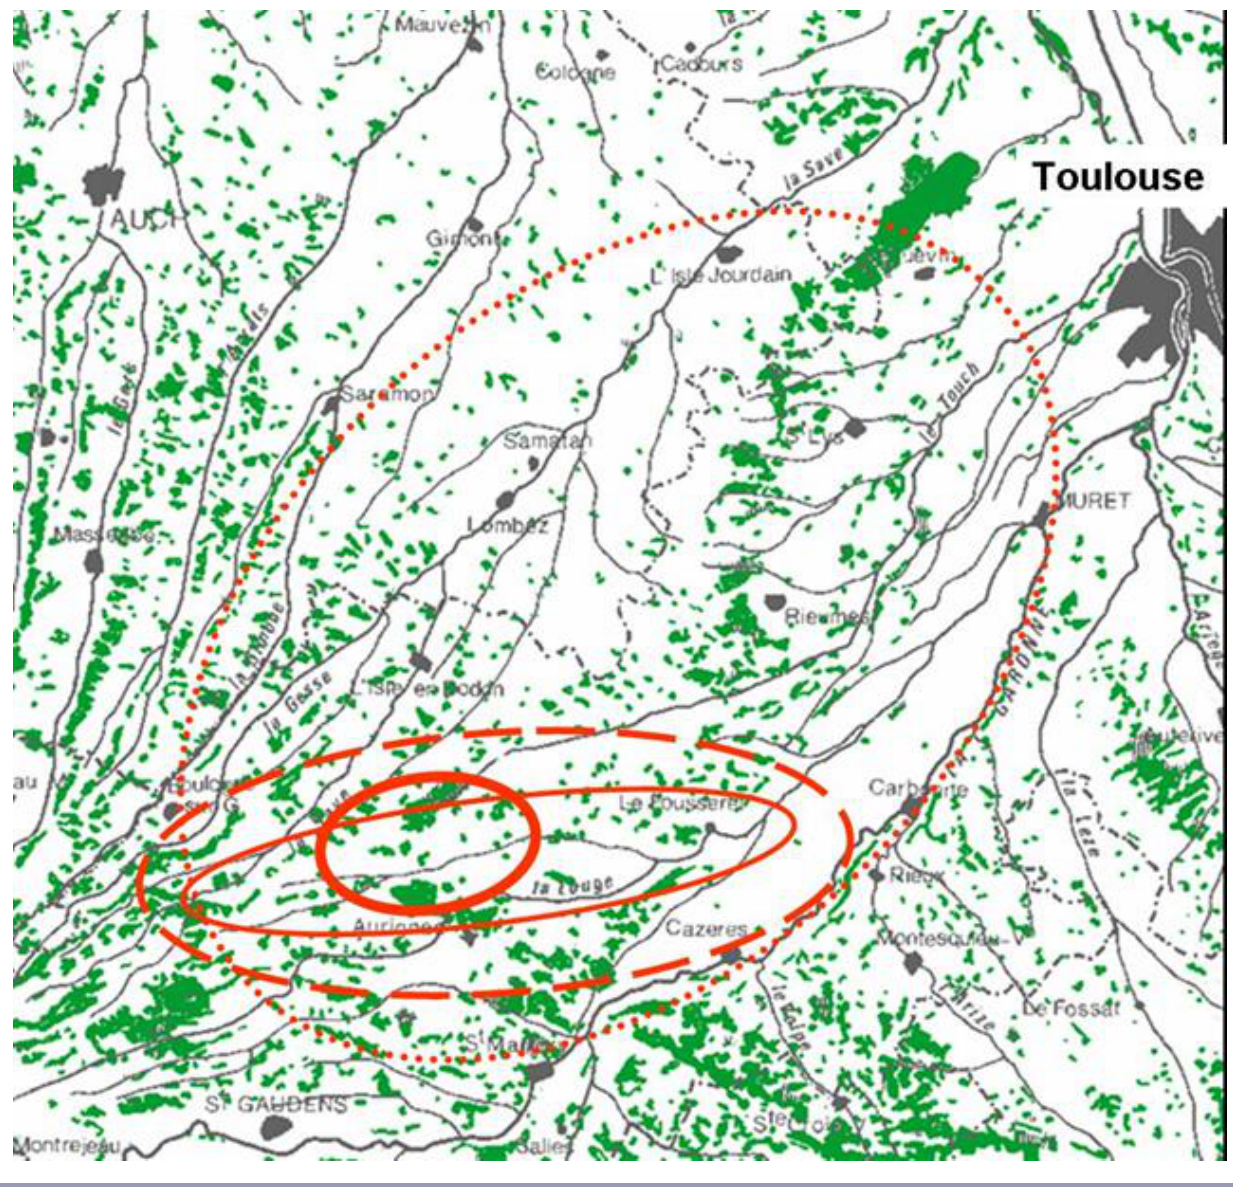
Fig. 1. Overlapping samples on the same study area. The study area was located in southwestern France, near Toulouse, in a rural region with croplands and pastures as a matrix (white) surrounding small woodlots and a few larger forests (green); towns, villages, and rivers are grey. The interdisciplinary research project had several sampling areas (shown by ellipses) according to the question addressed, but they overlapped as much as possible. The largest ellipse (dotted line) represents studies of bird/syrphid diversity in fragmented forests; the dashed-line ellipse represents tree diversity studies; the narrow red line ellipse represents roe deer and bird community dynamics; and the smallest ellipse (bold red line) represents fine-scale ecological studies combined with forestry and social studies that need detailed data (see Fig.